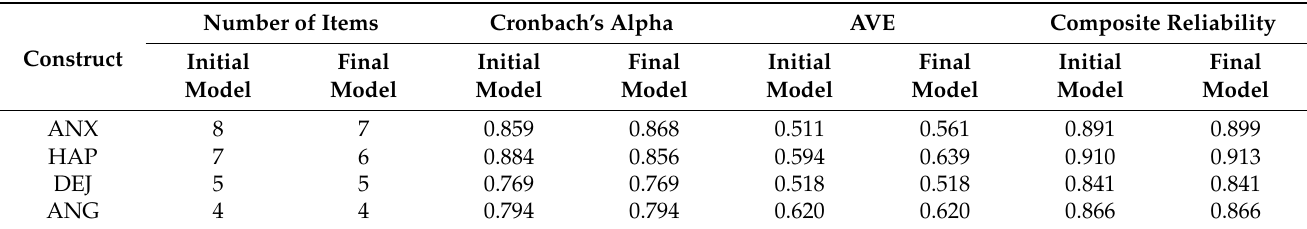
Table 5. Reliability and convergent validity